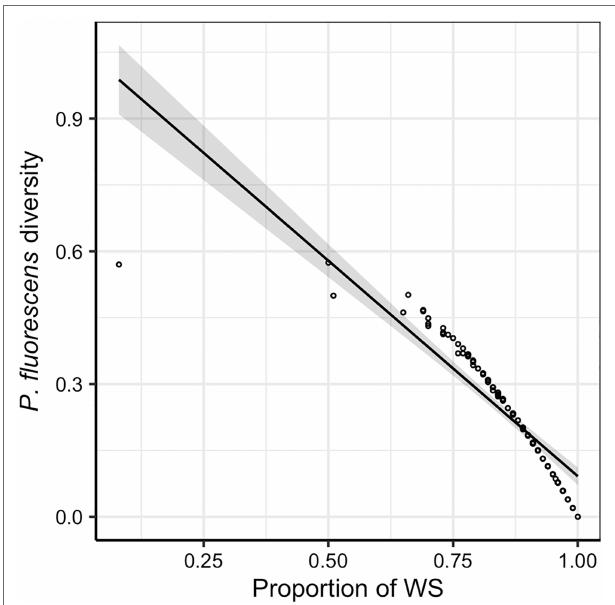
FIGURE 2 | Pseudomonas fluorescens diversity is negatively correlated with the proportion of wrinkly spreader (WS). The regression line represents a significant linear relationship and shaded areas around lines show the 95% confidence intervals: y 1.066 0.974x = − , F 1,94 = 369.820, p < 0.001, adjusted R 2 =